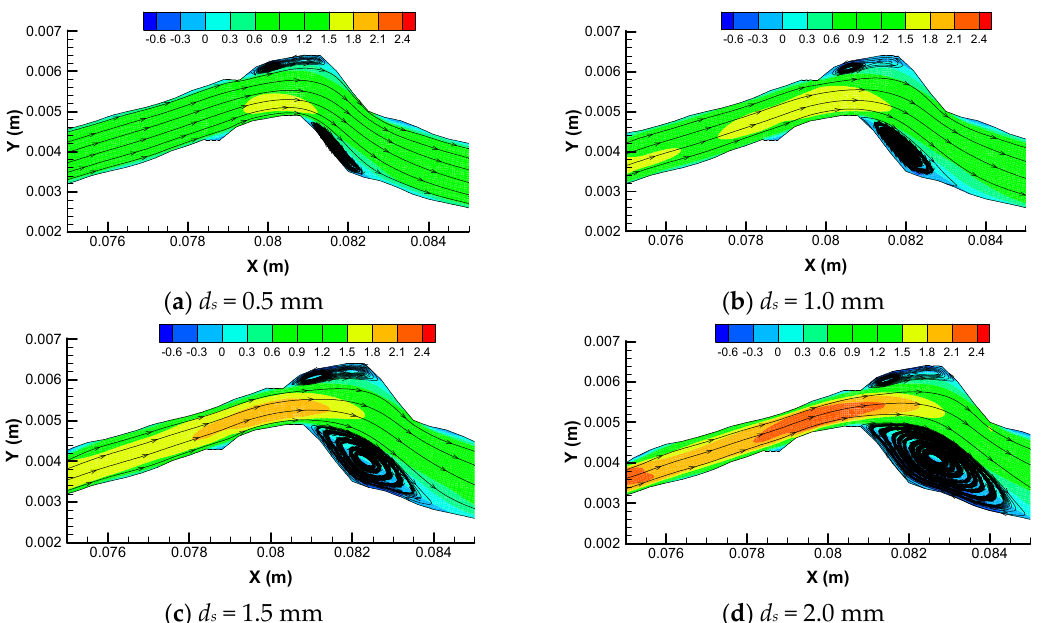
Figure 8. Eddy evolution with different JRCs, where Re = 1500 and d s = 2.0 mm.